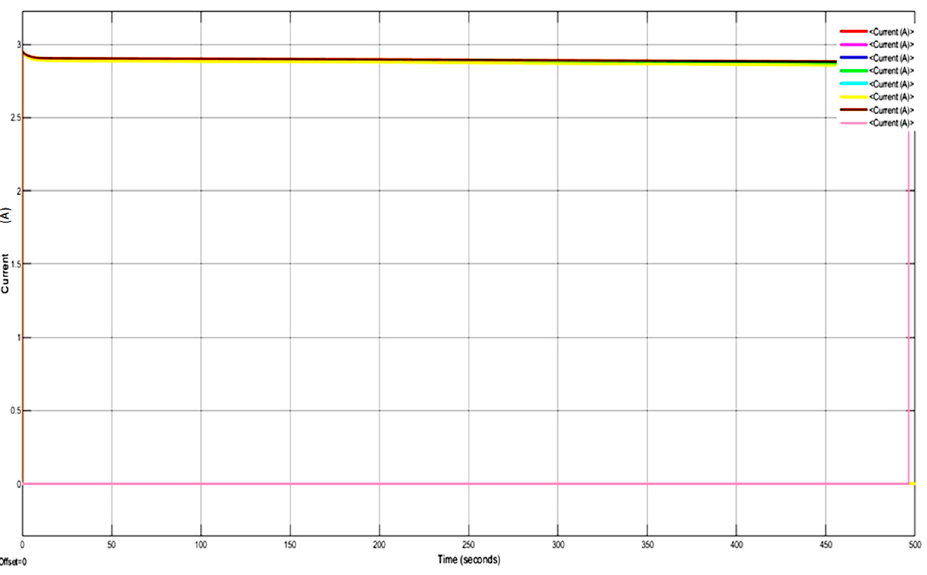
Figure 14. Primary current waveform in steady state for active cell balancing—Current (Ampere) vs. time (s) .